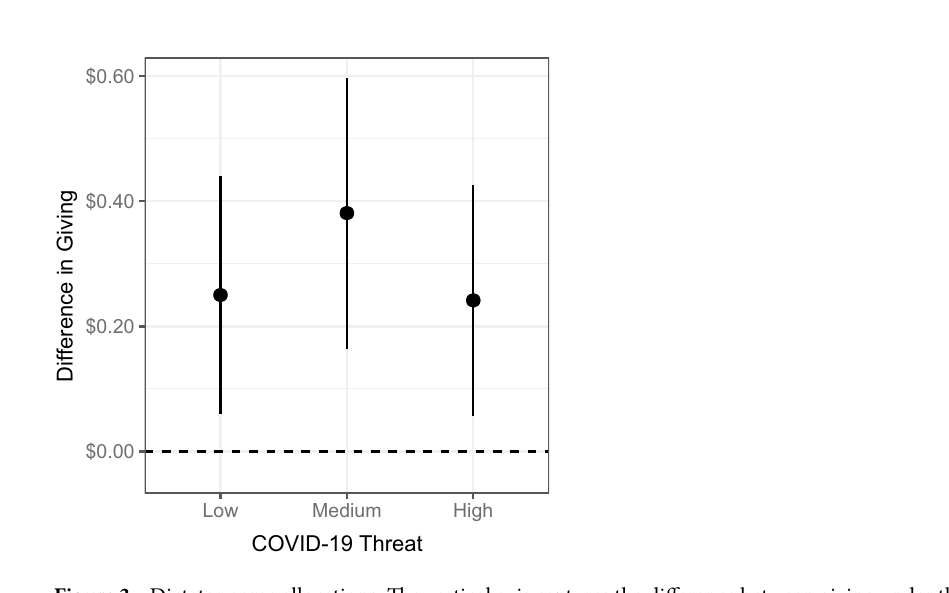
Figure 3. Dictator game allocations. The vertical axis captures the difference between giving under threat relative to no threat (dashed line). The horizontal axis indicates threat levels in each participant’s county at the time of the survey. Points and error bars represent regression coefficient estimates and 95% confidence intervals,